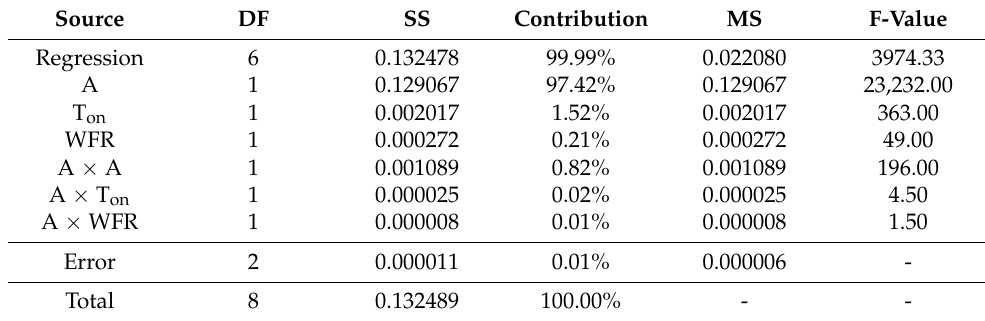
Table 9. Analysis of variance: kerf width—Al6351–5% SiC–8% B 4